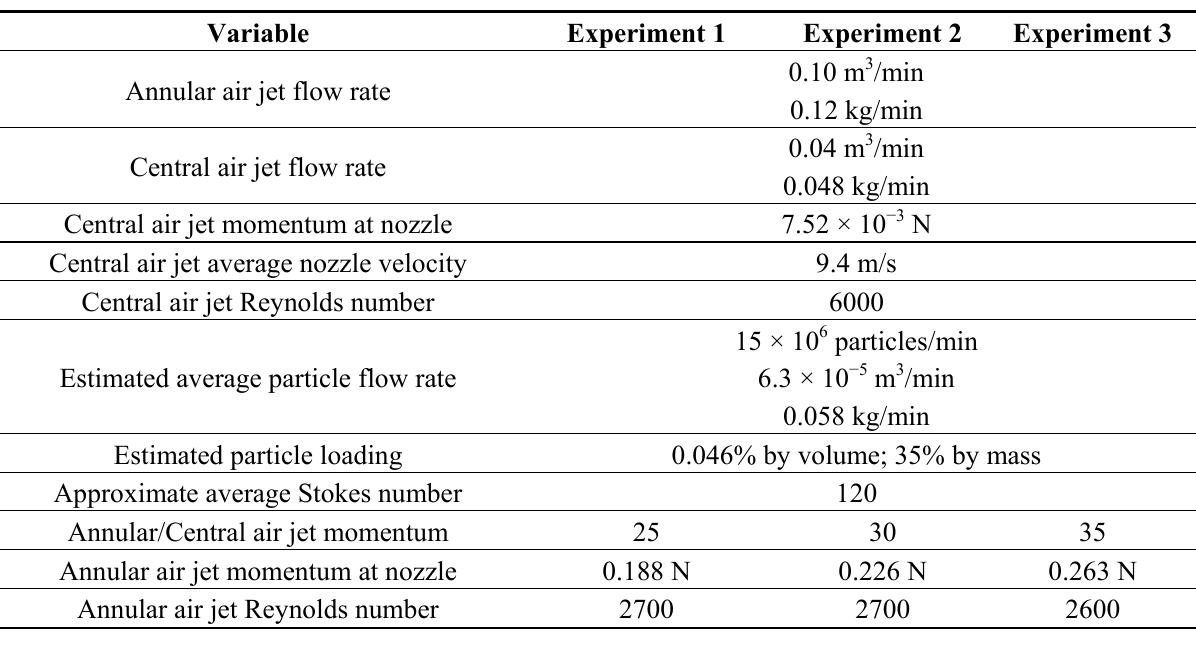
Table 3. The annular and central air jet properties used for experimental work with Gun Head